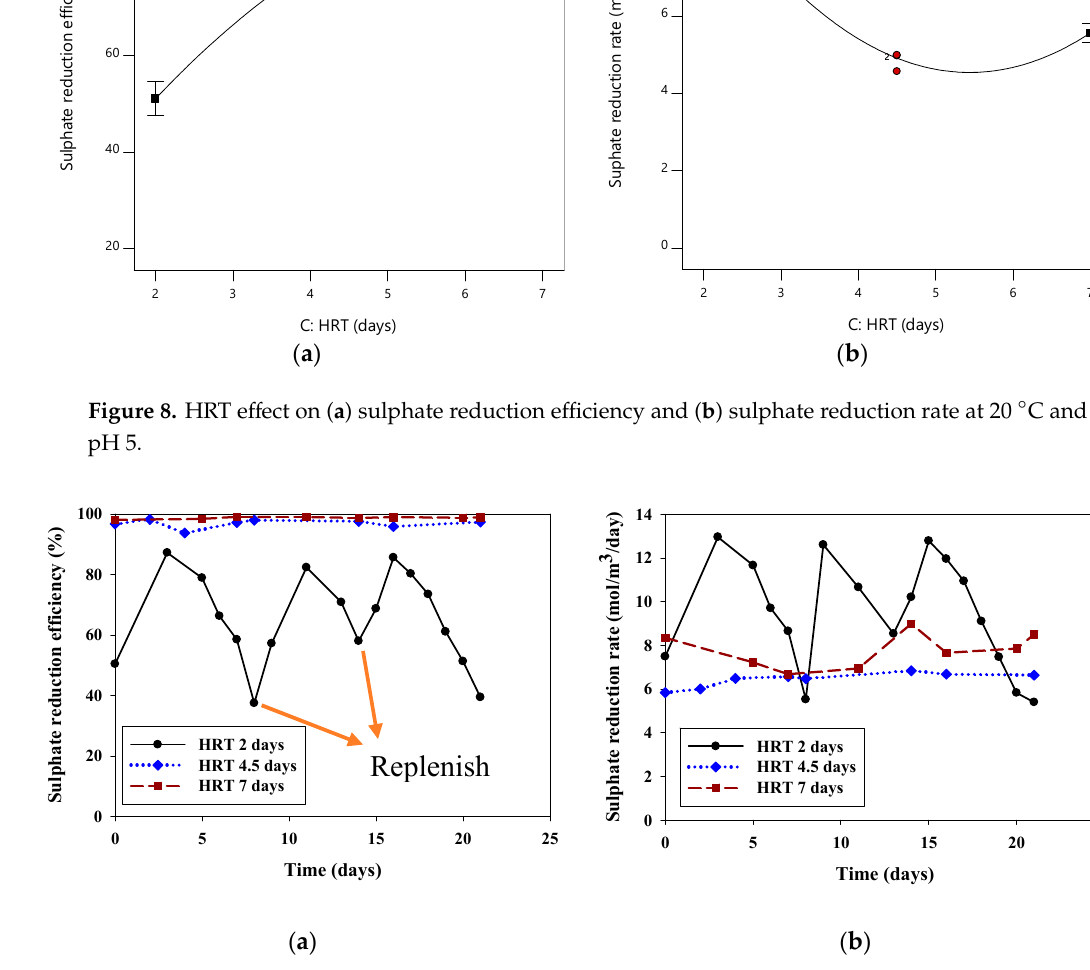
Figure 8. HRT effect on ( a ) sulphate reduction efficiency and ( b ) sulphate reduction rate at 20 °C and pH 5.